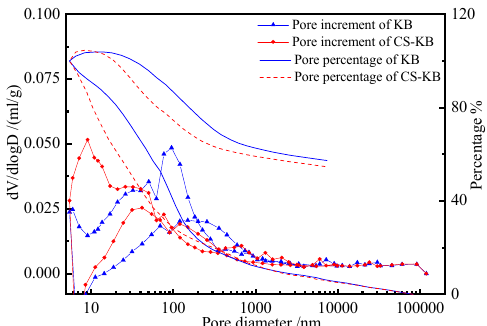
Figure 13. Curves of pore characteristics of mortar before and after sulfate attack.